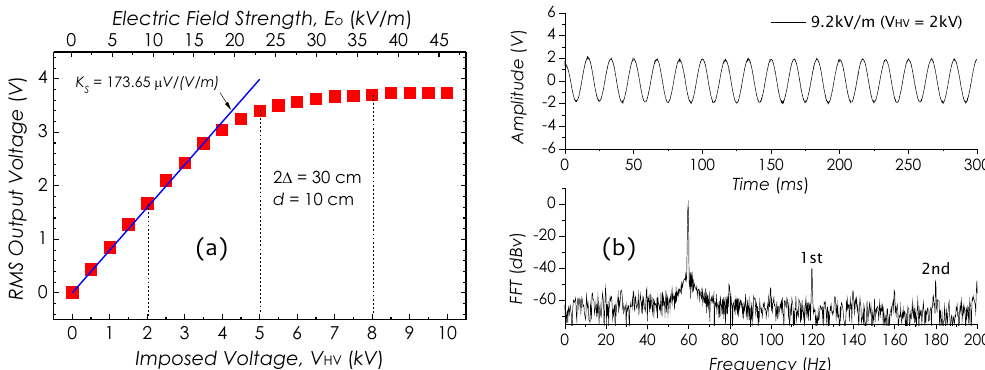
Figure 10. ( a ) RMS output voltage vs. imposed E -field strength E 0 or voltage V HV , and ( b ) a measured 60-Hz E -field signal waveform as E 0 = 9.2 kV/m ( V HV = 2 kV) and its FFT spectrum in 0 ∼ 200 Hz.